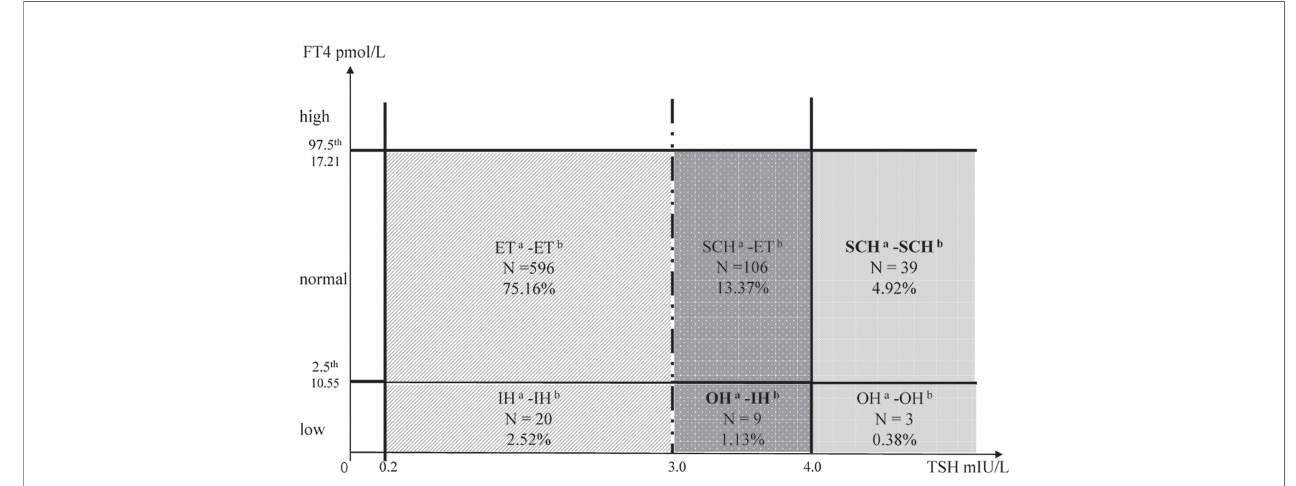
FIGURE 1 | Thyroid function grouped on different TSH thresholds. ET, euthyroidism; SCH, subclinical hypothyroidism; OH, overt hypothyroidism; IH, isolated hypothyroxinemia. a TSH thresholds at 3.0 mIU/L (2011 ATA guidelines). b TSH thresholds at 4.0 mIU/L (2017 ATA